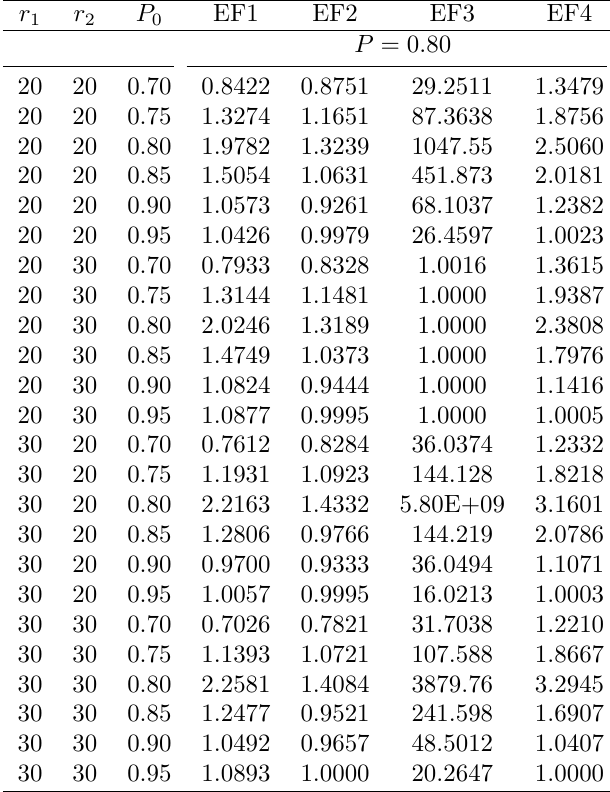
Relative efficiencies of the estimators for ’ P ’ under Type II